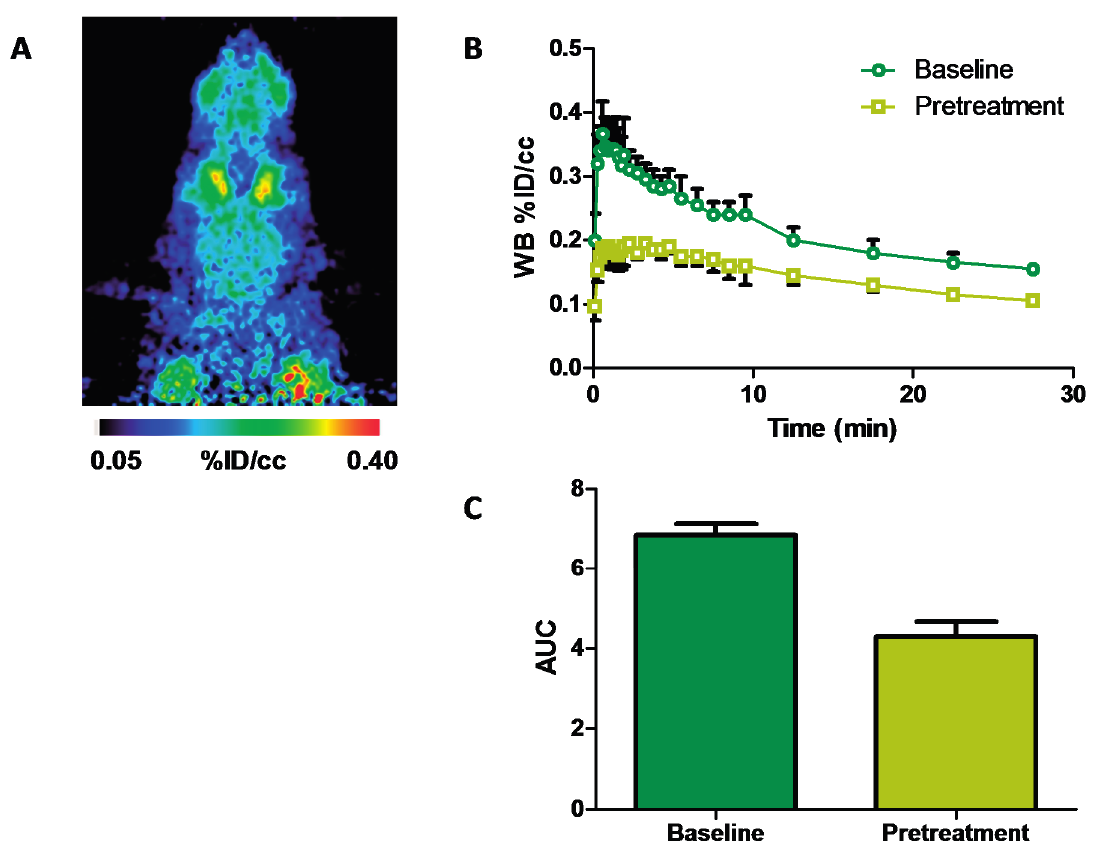
Figure 4. ( A ) Coronal view of summed image 0–7 min post bolus [ 11 C]isradipine injection at baseline; ( B ) time-activity curves in rat whole brain at baseline ( ) and after pretreatment ( ) with isradipine (2 mg·kg − 1 i.p., 30 min prior to time-of-injection (TOI)); ( C ) area-under-the-curve analysis of whole brain uptake 0–5 min after tracer injection at baseline and after pretreatment, paired t -test, p < 0.05; WB, whole brain; % ID/cc, percent of injected dose per cubic centimeter; AUC,